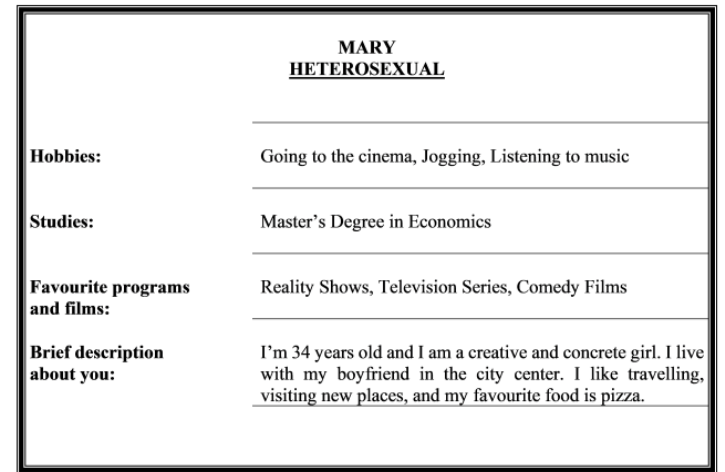
Figure A2. Heterosexual